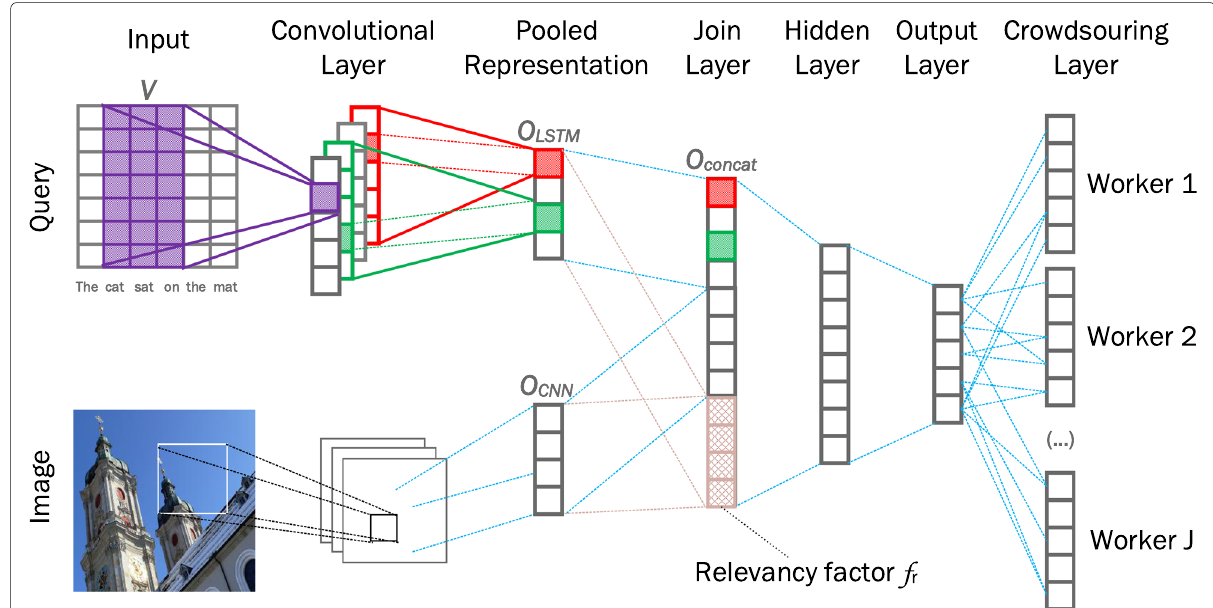
Fig. 3 Genaral structure. A general structure of our proposed method for relevance evaluation using deep learning, which assumes that the dataset contains 5 categories and J workers